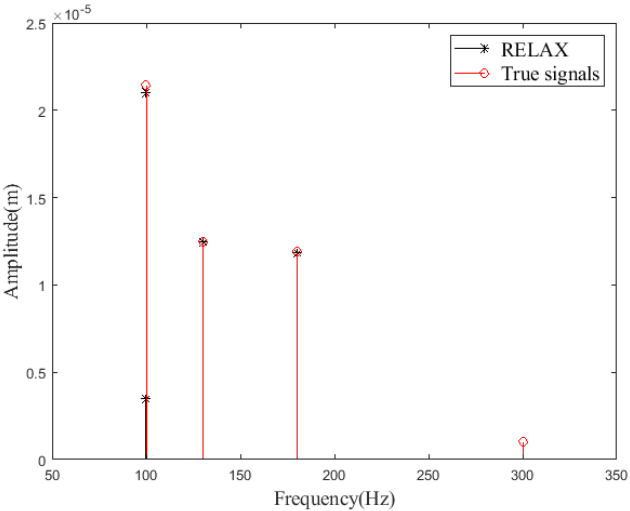
Figure 2. The underwater sound source sends 100 Hz, 130 Hz, 180 Hz, and 300 Hz signals, the RELAX fails to estimate the 300 Hz signals.